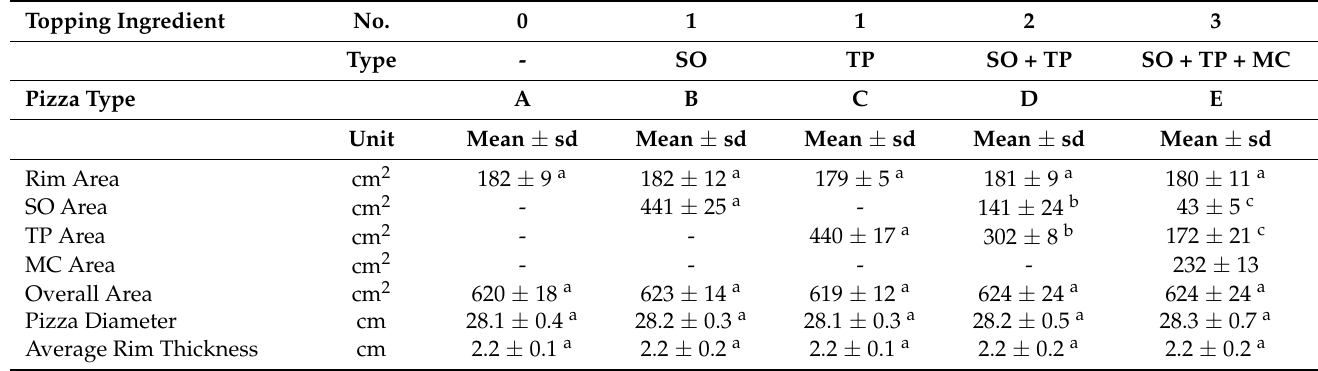
Table 2. Overall and partial areas of the pizza base as garnished with 1, 2, or 3 ingredients (SO, sunflower oil; TP, tomato puree; MC, mozzarella cheese), together with its average diameter and thickness of the raised rim.